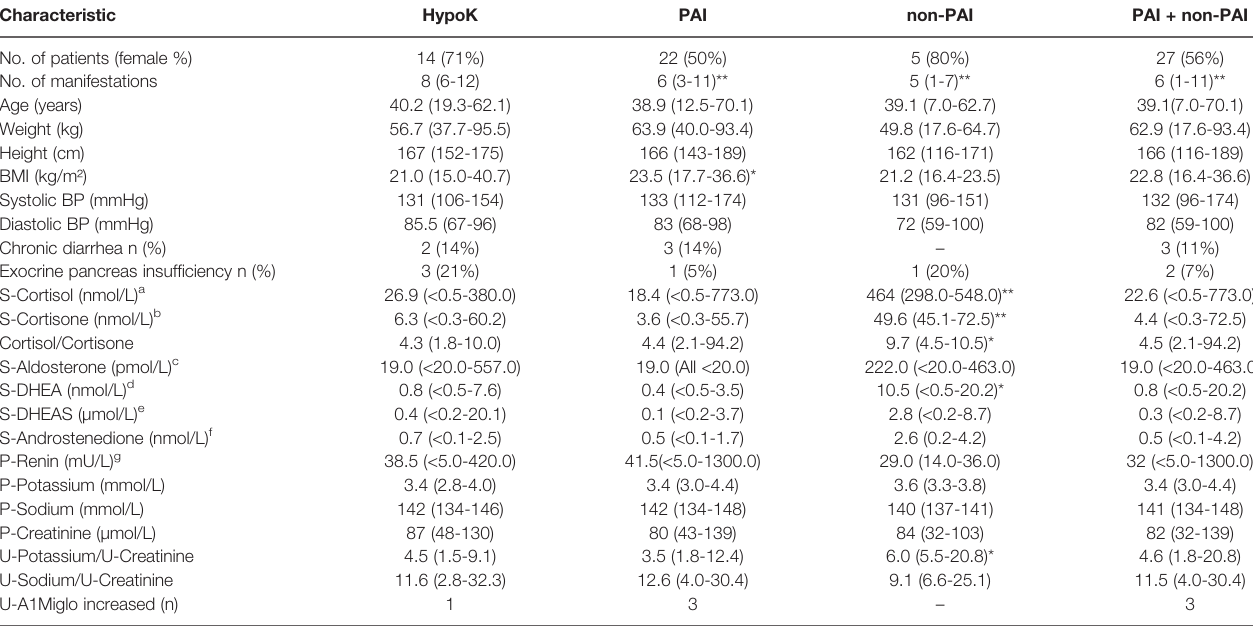
Results of other groups are compared with HypoK-patients and signi fi cant differences are shown. Resultsare presentedasmedian(range)unlessotherwise speci fi ed.BMI, body massindex;BP,blood pressure;S,serum; DHEA, dehydroepiandrosterone; DHEAS,dehydroepiandrosterone sulfate;P,plasma;U,urine;A1Miglo,alfa-1-microglobuline.**p<0.01,*p<0.05, a belowthelevelofquanti fi cationin2, b belowthelevelofquanti fi cationin4, c belowthelevelofquanti fi cationin 36, d below the level of quanti fi cation in 21, e below the level of quanti fi cation in 20, f below the level of quanti fi cation in 16, g below the level of quanti fi cation in 2.